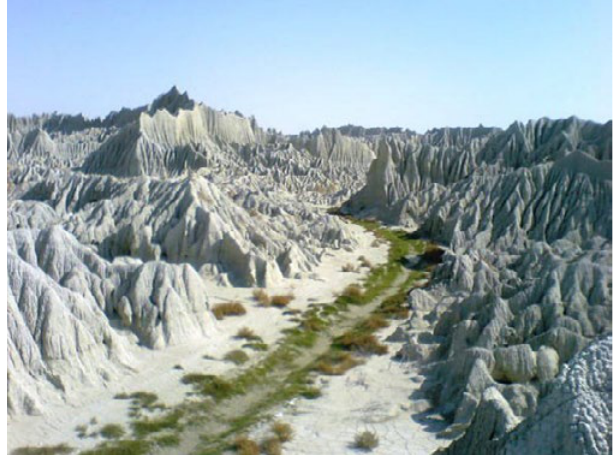
Fig. 1. Martian Fig. 1: Martian mountains